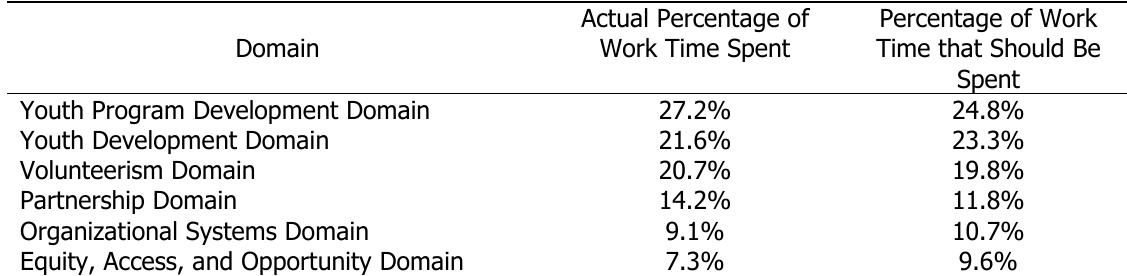
Self-Reported Percentage of Work Time Actually Spent and Where Work